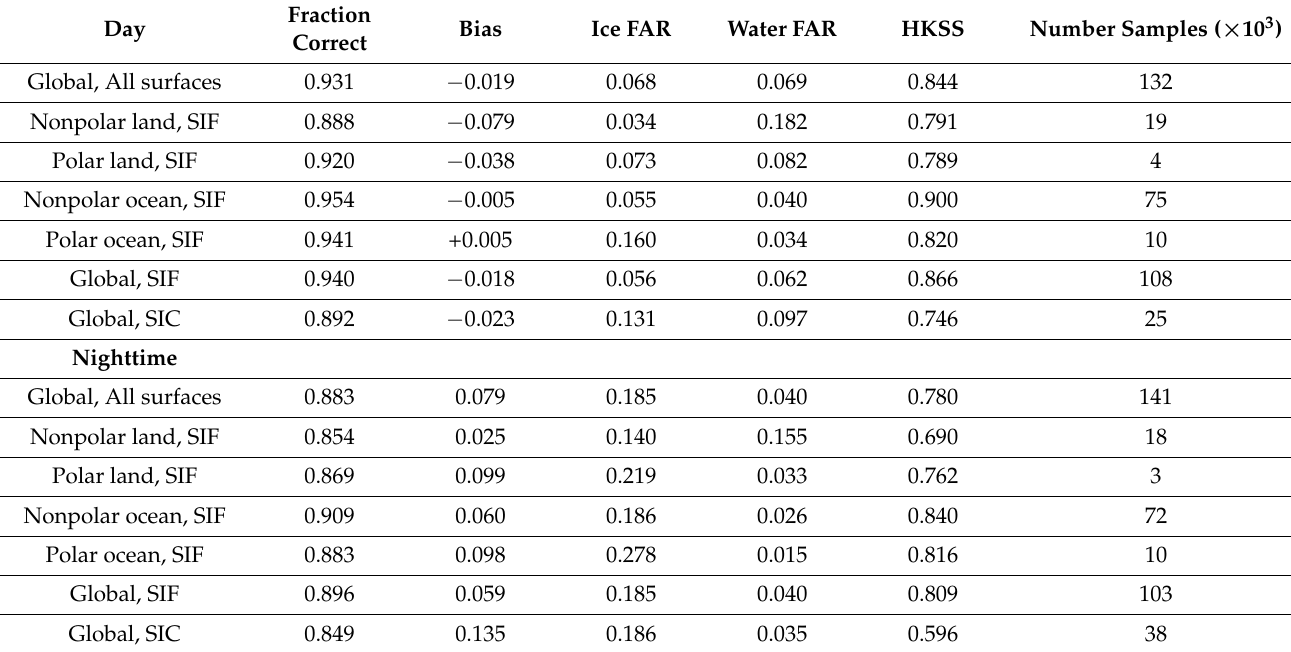
Table 3. CV1S cloud phase validation metrics for overcast (0/100 dataset) matches having a single phase or predominate phase using HA ≤ 5 km